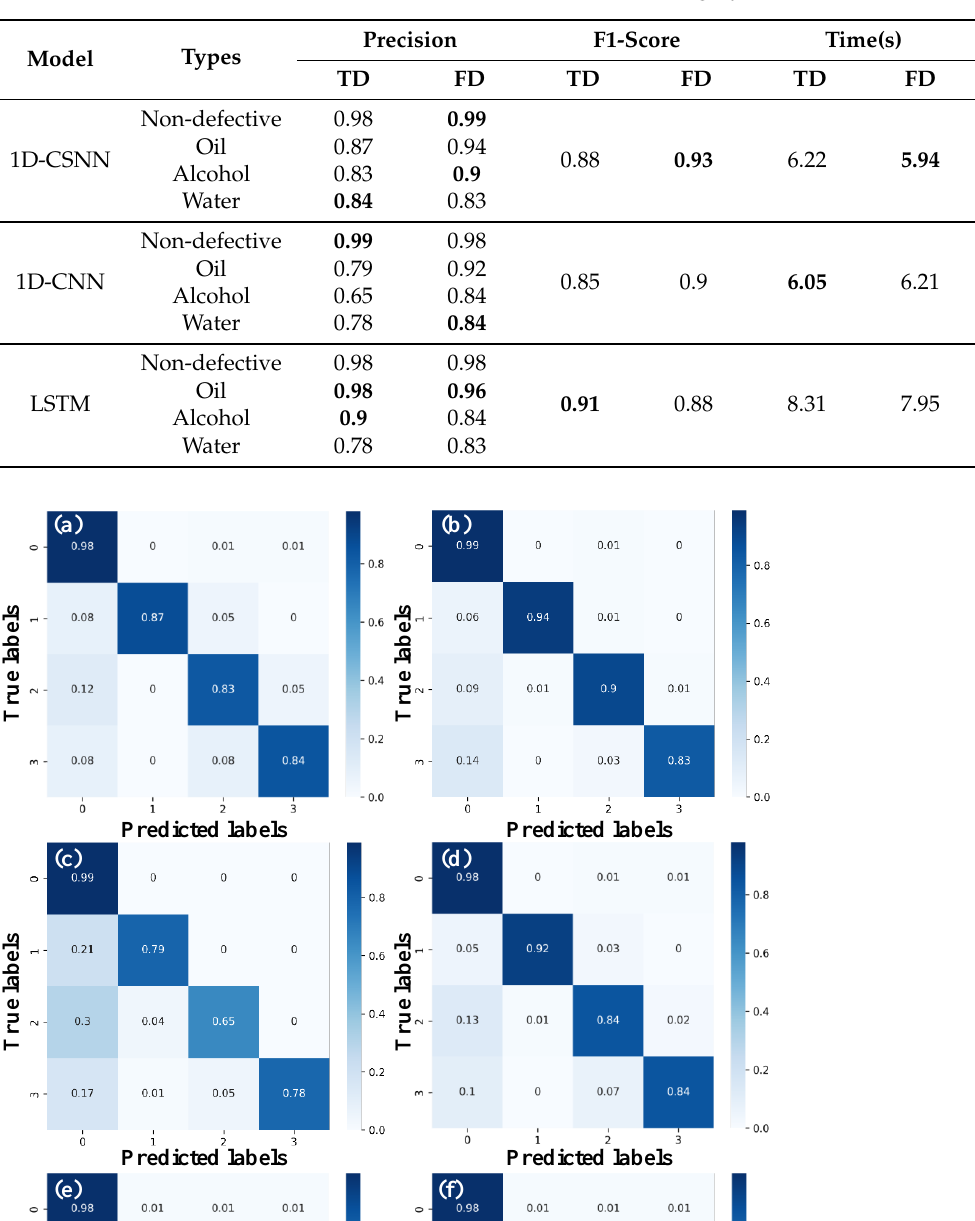
Table 2. Evaluations of three sequential models using time-domain and frequency-domain signals. Bold values indicate that the evaluation results are the best in each category.